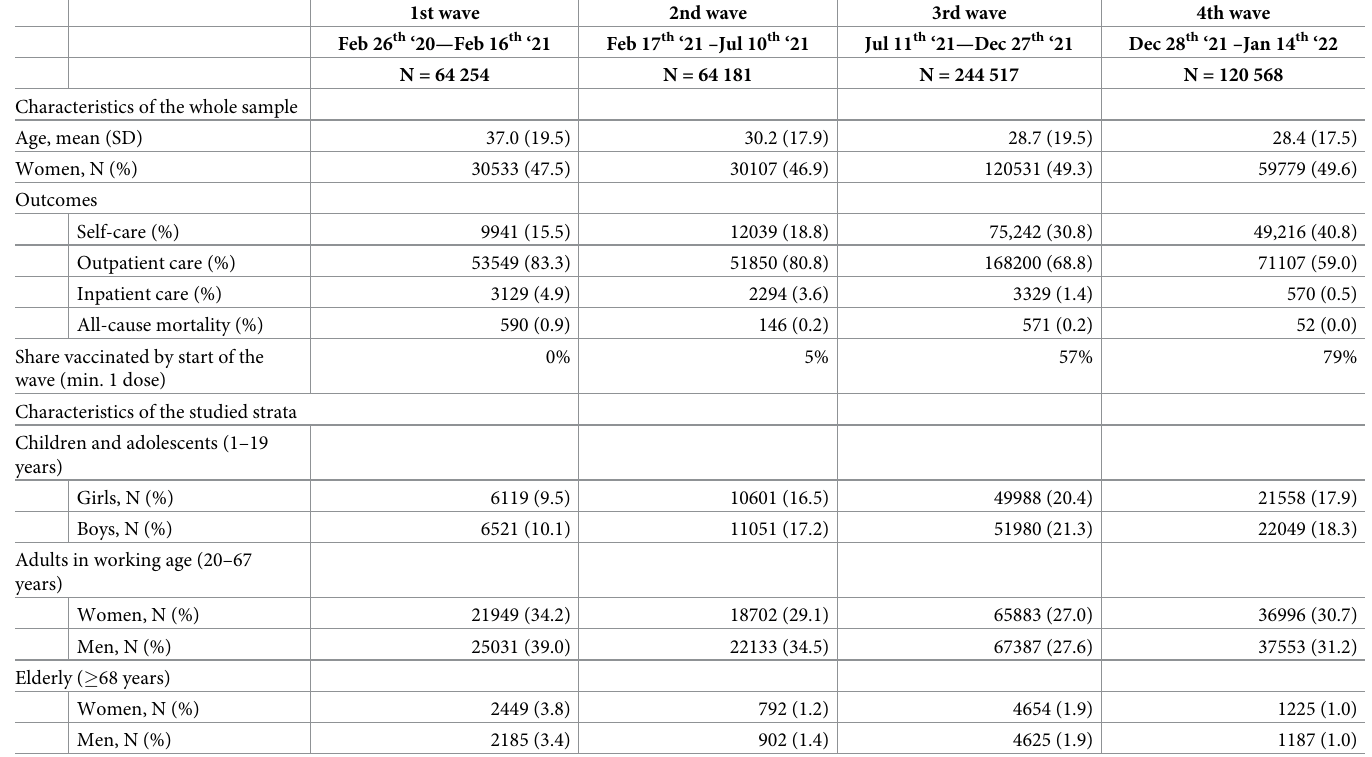
Table 1. Descriptive characteristics of persons testing positive for SARS-CoV-2 in each of four pandemic waves in Norway,